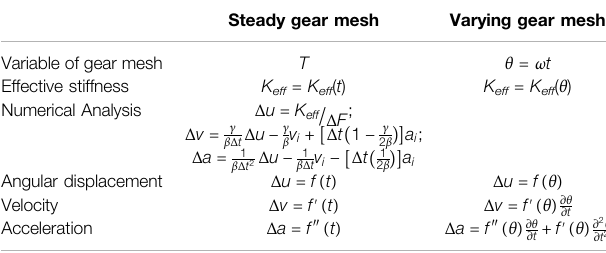
TABLE 1 | Comparison of the different gear mesh models. Steady gear mesh Varying gear